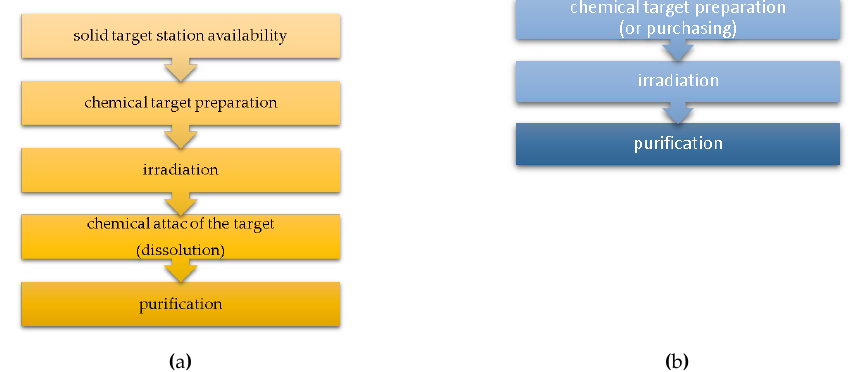
Figure 2. Radiometal cyclotron production approach through solid target ( a ) and liquid target ( b ) . Solid targets, in the form of metallic foil/coin, metallic powder or in oxide form, are mainly used for the cyclotron production of 99m Tc, 67 Ga, 111 In, 64 Cu, 61 Cu, 68 Ge, 103 Pd, and 89 Zr. For example, highly enriched 100 Mo targets are used for the direct cyclotron 99m Tc production, via the 100 Mo(p,2p) 99m Tc nuclear reaction while cadmium solid targets, highly enriched in the isotope 112, are commonly used for the cyclotron production of indium-111 via 112 Cd(p,2n) 111 In nuclear reaction [31,32]. In Table 2 different type of target used for the cyclotron production of the selected radiometals are reported. Table 2. Type of target used for the cyclotron production of the selected radiometals. Radionuclide Target Type Chemical form of the